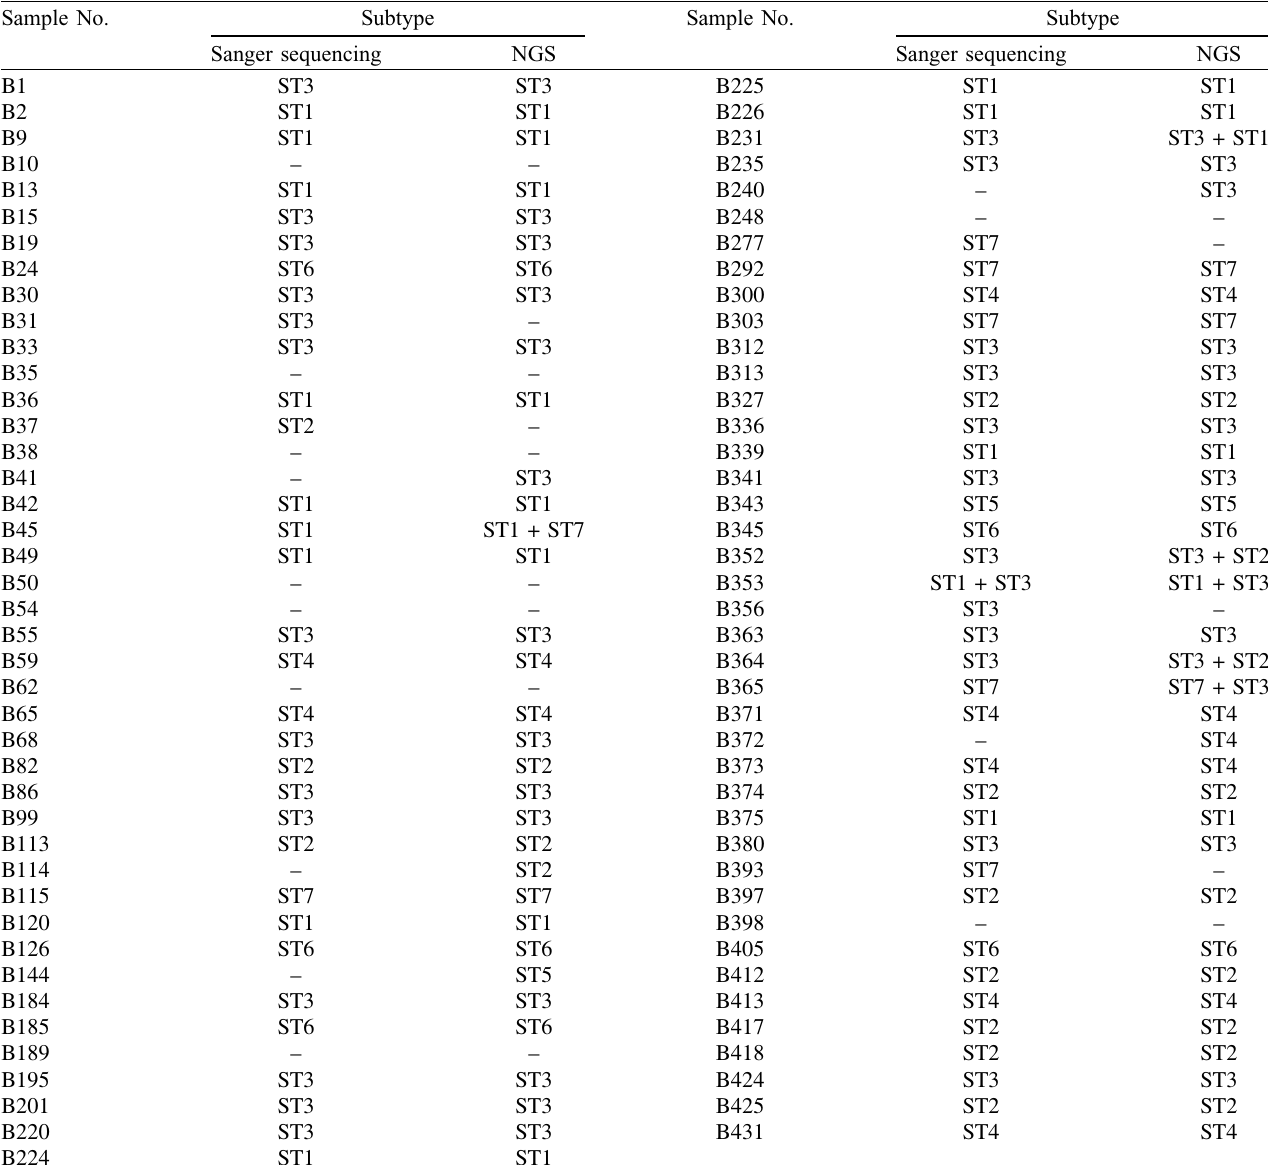
Table 4. Comparison of Blastocystis subtype data in a set of 83 qPCR-positive samples obtained by Sanger sequencing (results obtained in previous study Lhotská et al., 2020) and next-generation sequencing (NGS). Sample